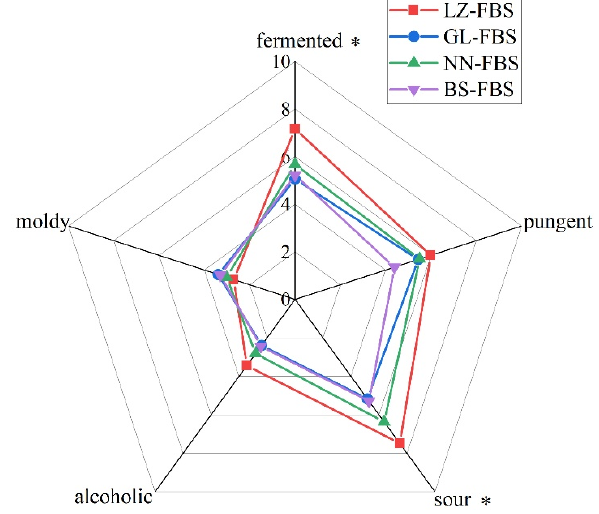
Figure 1. Sensory characteristics of Guangxi fermented bamboo shoots (GFBS) from different regions of Guangxi. * significant ( p ≤ 0.05).